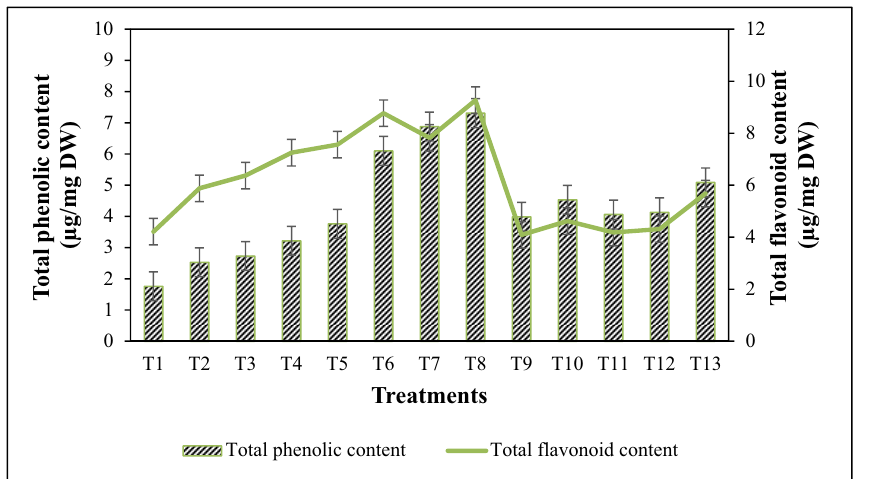
Figure 8: E ff ect of di ff erent treatments of NPs alone or in combination with TDZ on total phenolic content and total fl avonoid contents in callus cultures of A. absinthium